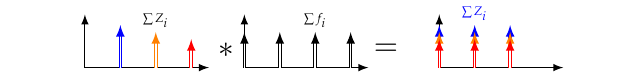
Figure 5. Conceptual representation of impedance spectroscopy based on multi-frequency excitation and coherent sampling in frequency domain. Table 1. Expected characteristics of impedance estimation